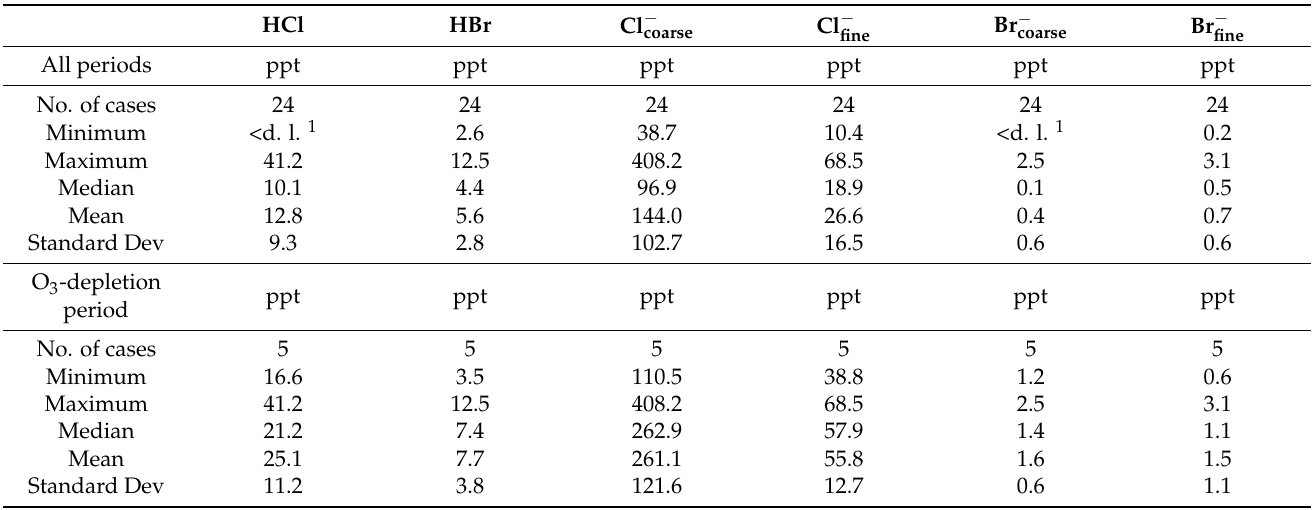
Table 2. Statistics for halogen compound concentrations during the Arctic campaign of